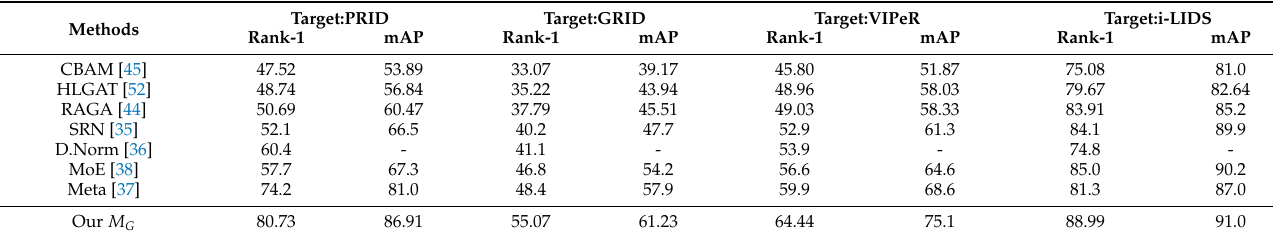
Table 2. Results on Naïve Close-Set Setting#1.